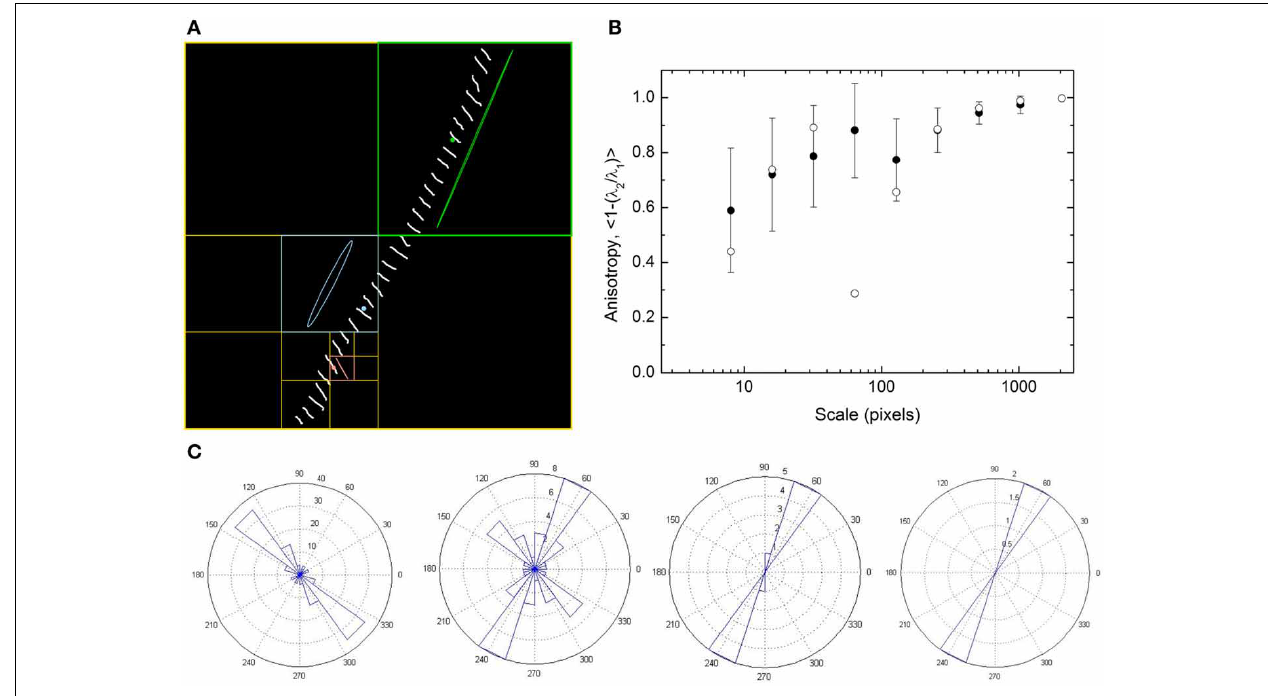
FIGURE 3 | Two artificially separated length scales. (A) Synthetic image with two well-defined anisotropy length scales. Inertia tensor in three boxes, each at a different scale, is represented using superimposed ellipses. Colored points label the barycenter of the signal. Image side : 2048 pixels. Box size : pink 128, blue 512, green 1024 pixels. (B) Anisotropy graph. Closed circles: average anisotropy